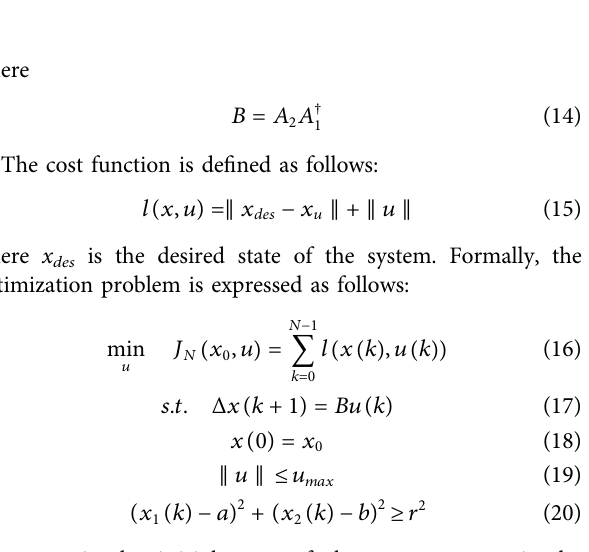
FIGURE2| SimulatedandphysicalexperimentationofKMFcontrolandtheproposedKMF-PCintheabsenceofanyobstacle.Comparingsimulationresults (A,B) , both controllers performed similar, reaching the target in a semi-straight line. As for the physical experiments (C,D) , we notice that the KMF-PC took a slightly more curved path to reach the target position. Nonetheless, both KMF and KMF-PC performed similarly well, achieving the reaching task within 30 steps.